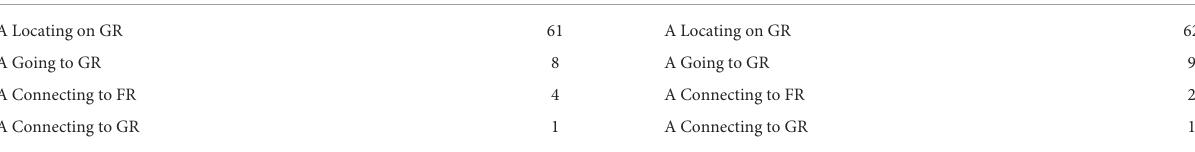
TABLE 2 Narrative projections of legs and